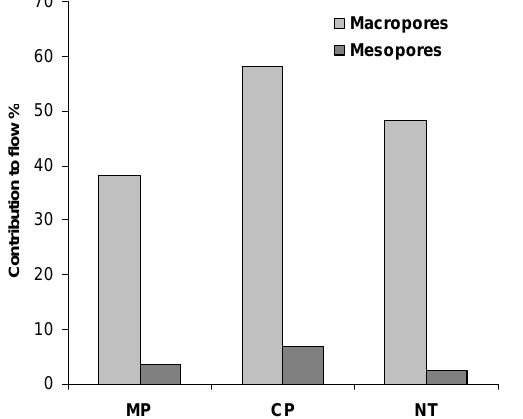
Figure 5. Soil organic carbon (SOC, %) in the principal axes and soil organic carbon stock (SOC, gm − 2 ) in the secondary axes of the treatments: moldboard plow (MP), chisel plow (CP) and no till (NT). Different letters indicate significant differences among treatments ( p